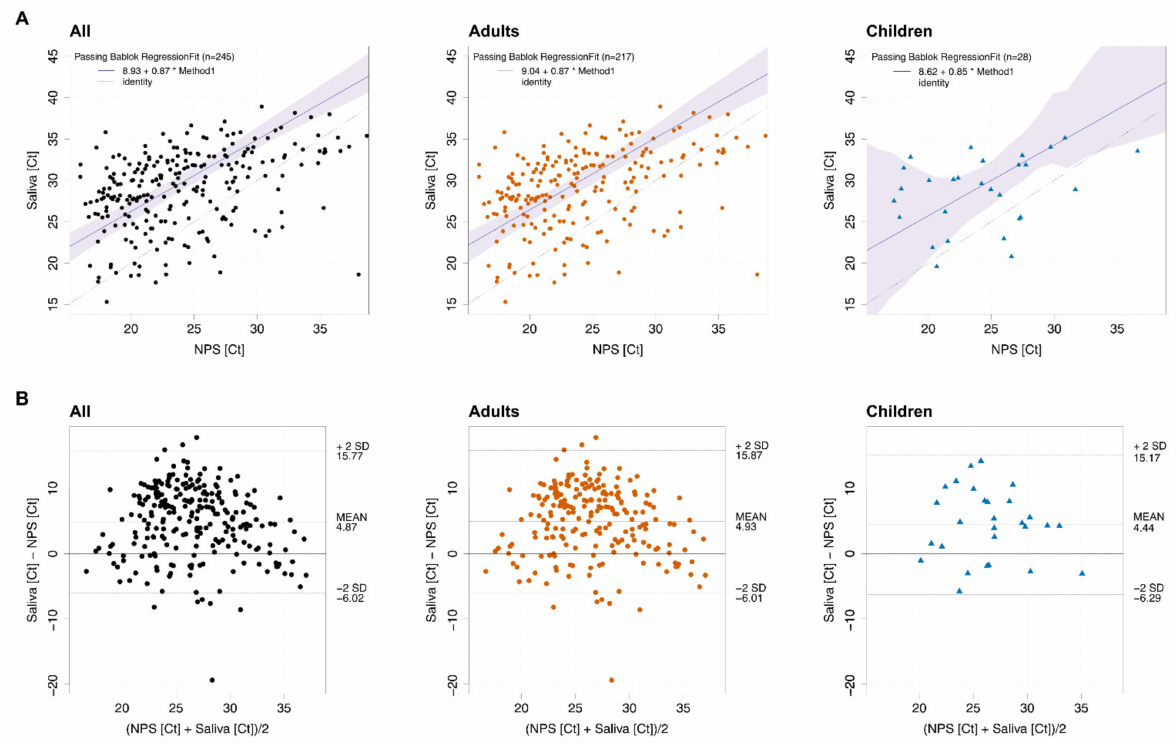
Figure 2. SARS-CoV-2 levels in saliva and nasopharyngeal swabs correlate. ( A ) Passing–Bablok regression of E-gene Ct values of NPS and saliva of all positive pairs from the full cohort (N = 245; p < 0.0001), adults (N = 217; p < 0.0001) and children (N = 28; p = 0.079). Black dashed line equals identity, blue line shows linear trend. ( B ) Bland–Altman plot of E-gene Ct values of NPS and saliva of all positive pairs from the full cohort (N = 245), adults (N = 217) and children (N =